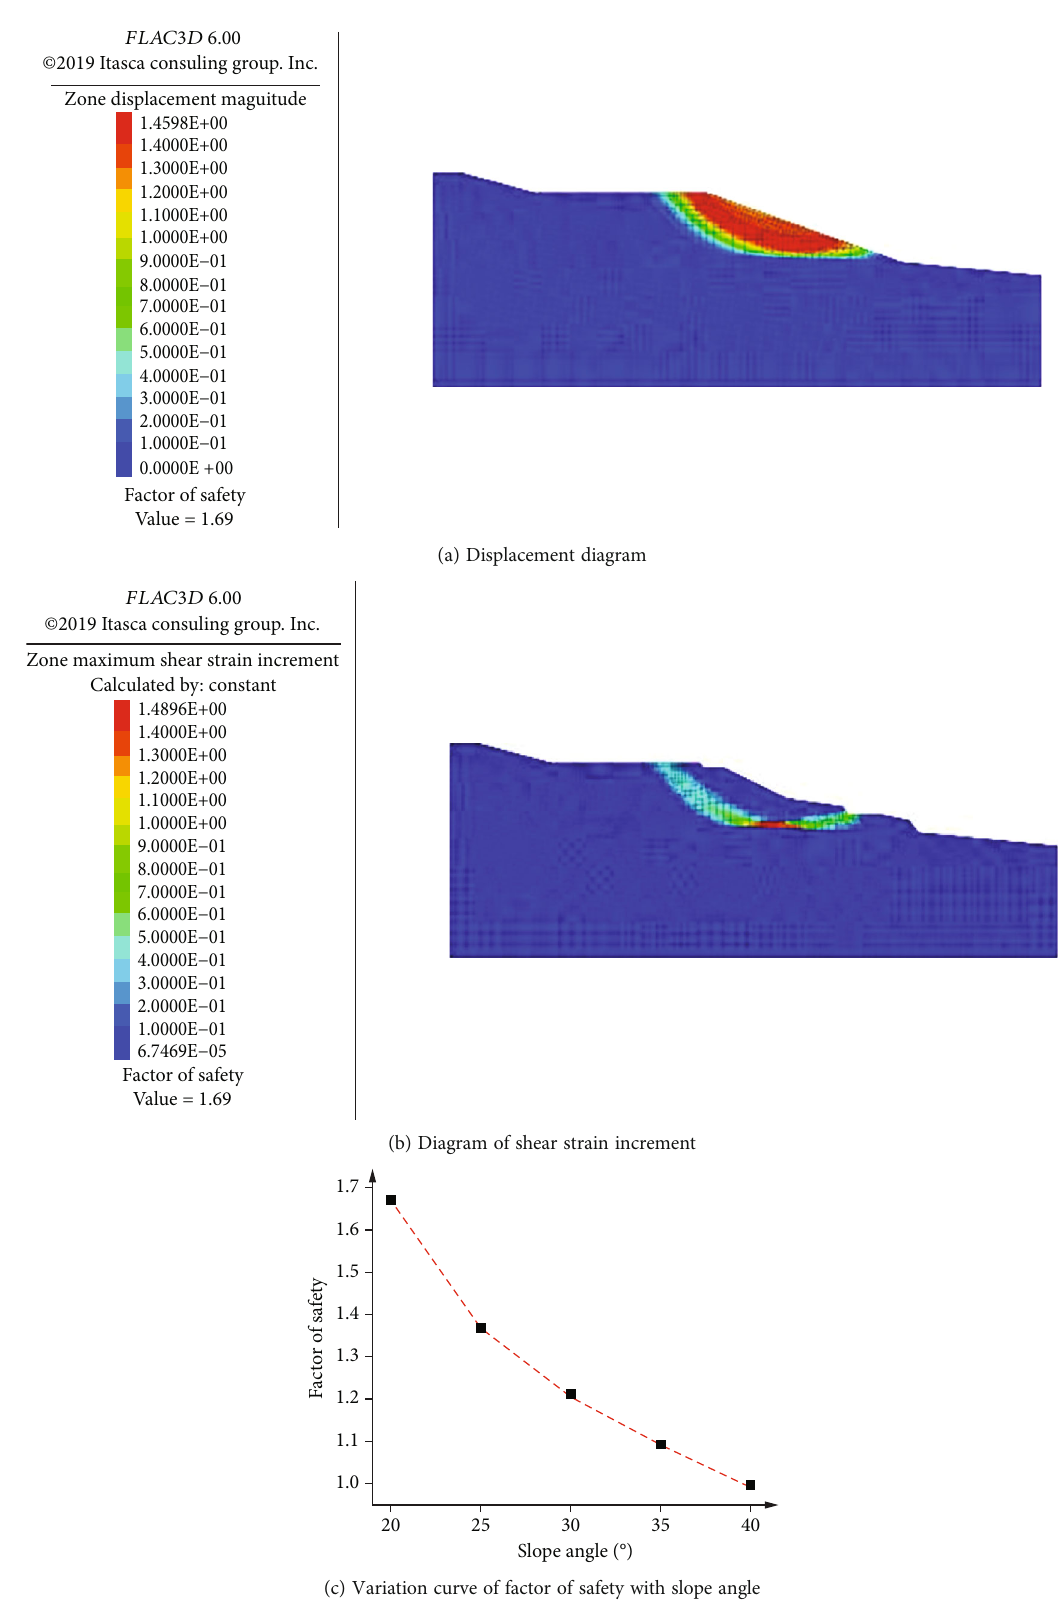
Figure 20: E ff ect of slope angle on slope